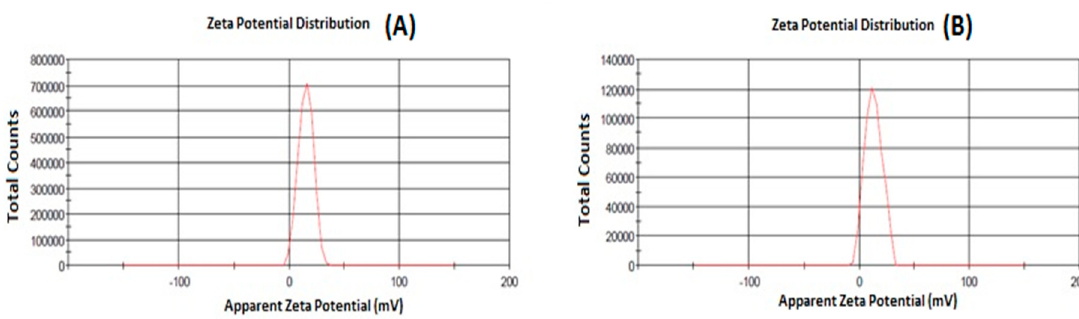
Figure 3. Microphotograph of NAR NPs by ( A ) Transmission Electron Microscope (TEM) and ( B ) Field Emission Scanning Electron Microscope (FESEM). 3.3. In Vitro Drug Release The in vitro release of NAR from the NPs is shown in Figure 4. NAR release from NPs in vitro showed an initial rapid release (20.64 ± 1.35%) for 2 h, followed by a slow release (54.80 ± 4.22%) for 24 h. The initial rapid release could be due to the presence of drug molecules on the surface of the NPs [25]. The slow and sustained release of NAR from NPs was due to the presence of entrapped drug in the matrix. The slow drug release from the matrix could be due to penetration of fluid media into the matrix by diffusion mechanism, thus converting the polymer matrix system into a rubbery state which is then degraded or eroded [25]. All these mechanisms take place simultaneously leading to controlled release of NAR from NPs.